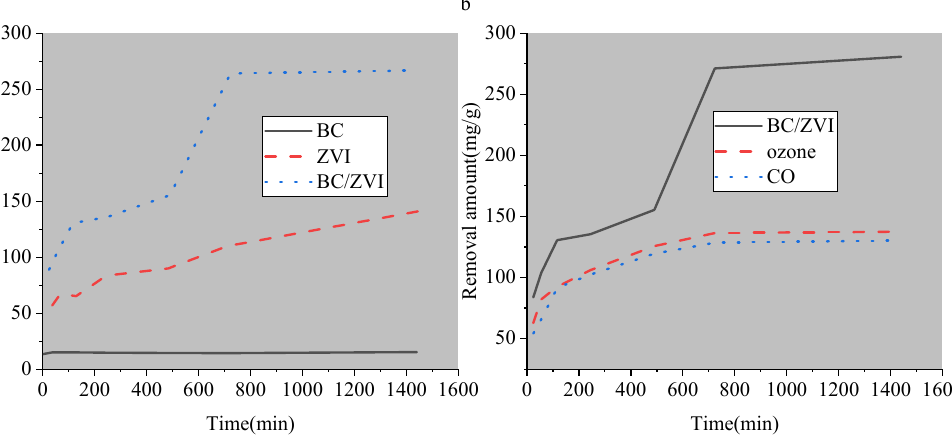
Figure 3. Performance evaluation of BC composite (( a ) is the TC removal effect of BC composite, and ( b ) is the comparison of TC removal effect under the use of different catalysts).